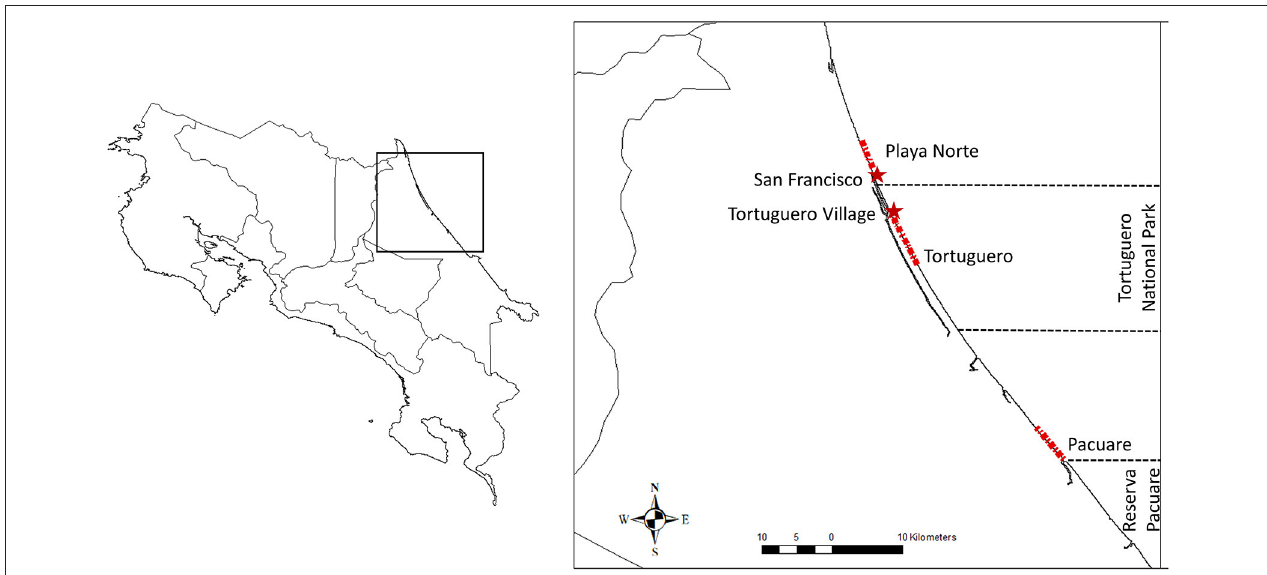
FIGURE 1 | Playa Norte, Tortuguero, and Pacuare research transects monitored by Caño Palma Biological Station, Sea Turtle Conservancy, and Latin American Sea Turtles, respectively.